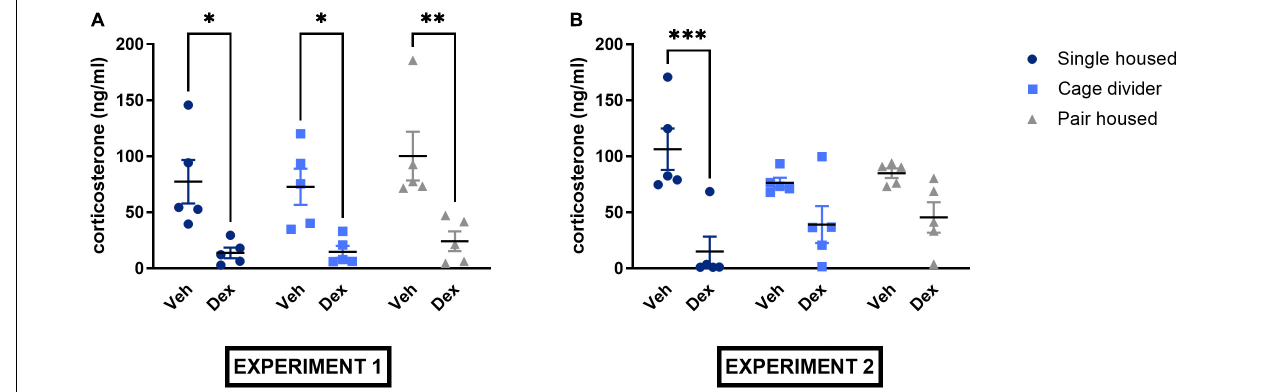
FIGURE 5 | Plasma corticosterone concentrations of single housed, pair housed and pair housed mice with a cage divider subjected to the dexamethasone suppression test. (A) Plasma corticosterone levels from the dexamethasone suppression test of experiment 1. (B) Plasma corticosterone levels from the dexamethasone suppression test of experiment 2. Data are presented as mean ± SEM. n = 5 mice/treatment group. Statistical analysis: Ordinary Two-Way ANOVA with Sidak’s multiple comparisons test for comparisons between mice receiving dexamethasone and vehicle. ∗ P < 0.05, ∗∗ P < 0.01, ∗∗∗ P < 0.001. Dex, dexamethasone; Veh,